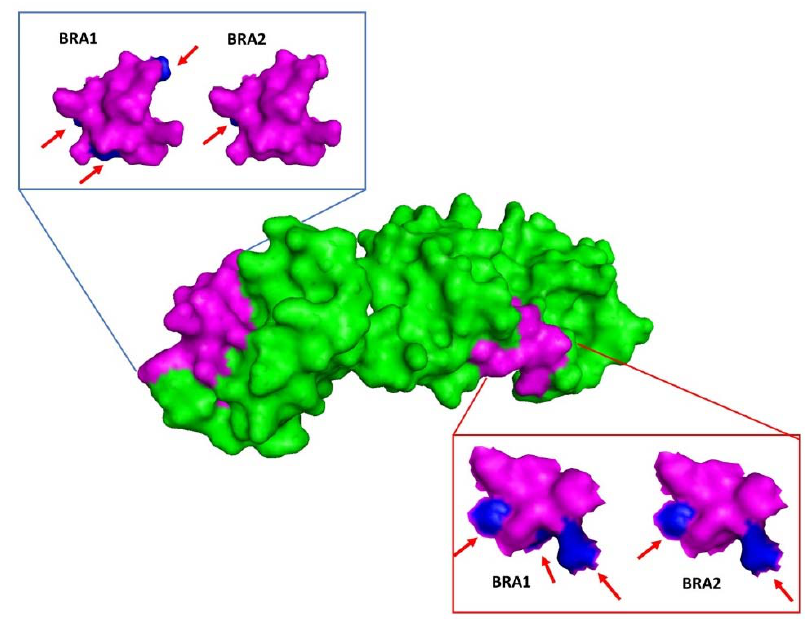
Figure 3. Molecular modelling of BRA1 and BRA2 p26 using a p26 crystallographic structure (PDB code 1EIA) with Modeller software. Epitopes with amino acid alterations were compared in both models, showing surface residue alterations. Blue arrows point to amino acid alteration compared to the reference.